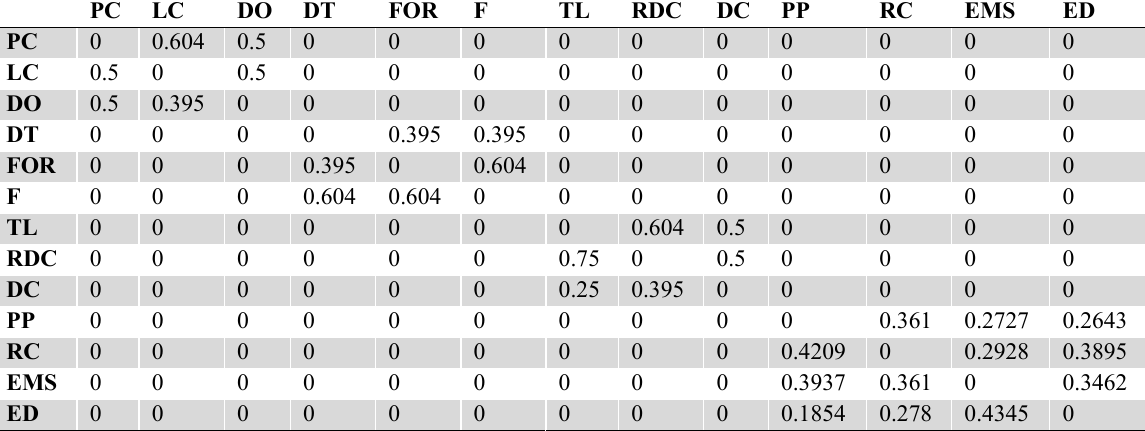
The initial large normal matrix before